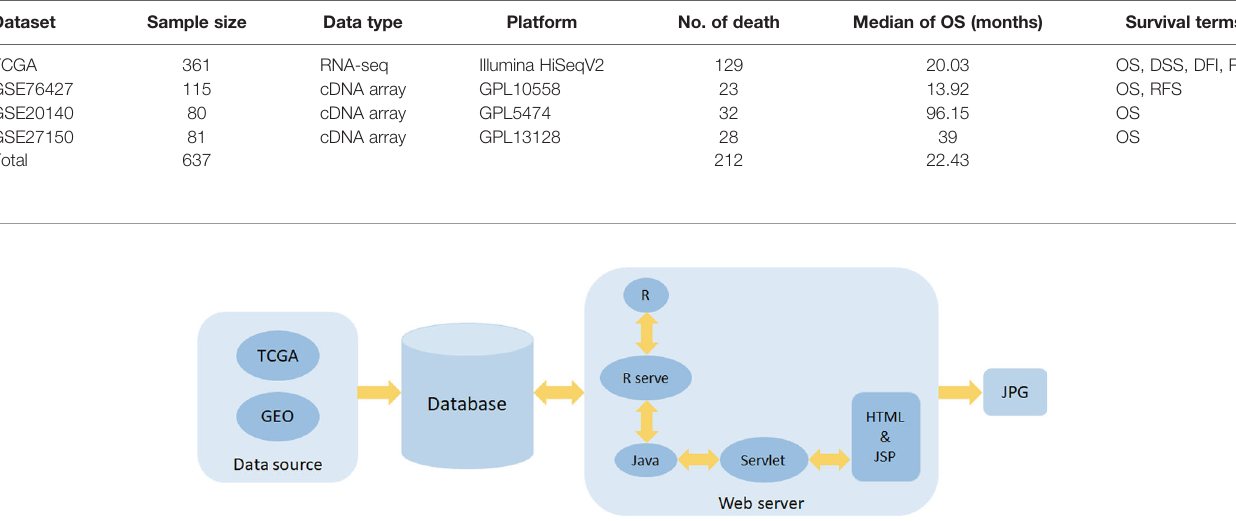
TABLE 1 | Summary of datasets in OSlihc.